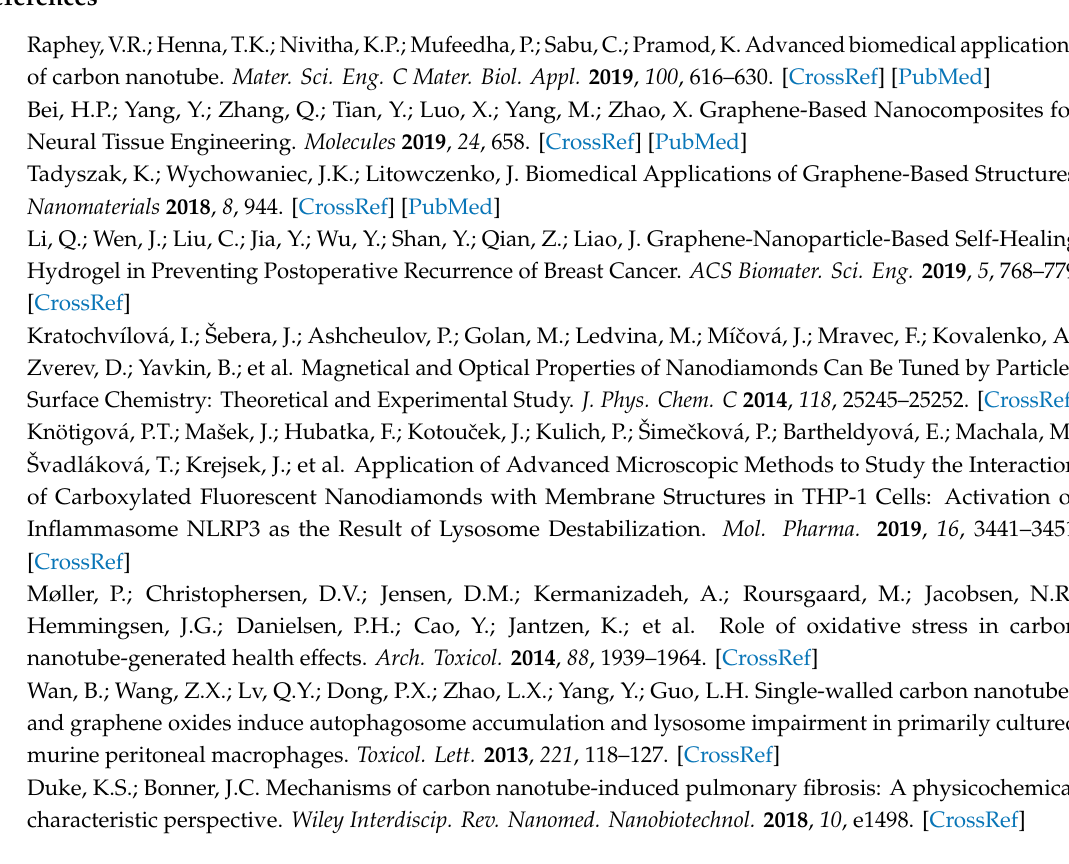
Figure S1: XRD patterns of studied C-BNM. Table S1: Elemental composition of C-BNM. Figure S1: Raman spectra of MWCT, GP1 and GP2. Figure S3: TGA (left Y-axis) and TGA (right Y-axis) curves recorded for C-BNM under oxygen atmosphere with a heating rate of 10 K / min. Figure S4: Monocytes response to C-BNM; Percentage of cytotoxicity via LDH assay after 24 and 48